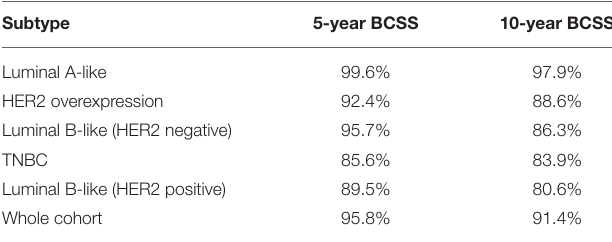
TABLE 5 | 5- and 10-year breast cancer–specific survival (BCSS).